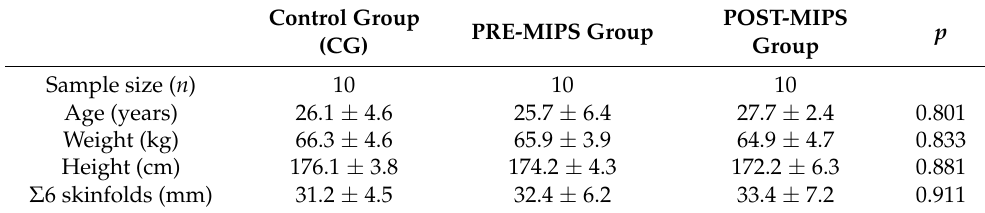
Table 1. Anthropometry and body composition data in the three study groups at baseline of